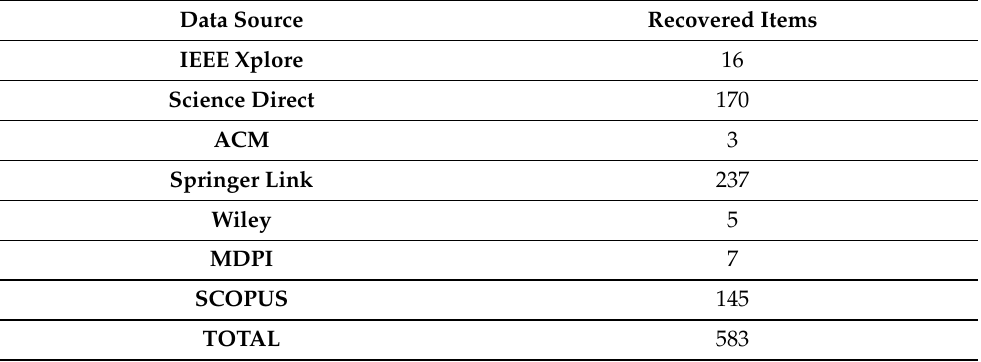
Table 2. Data source